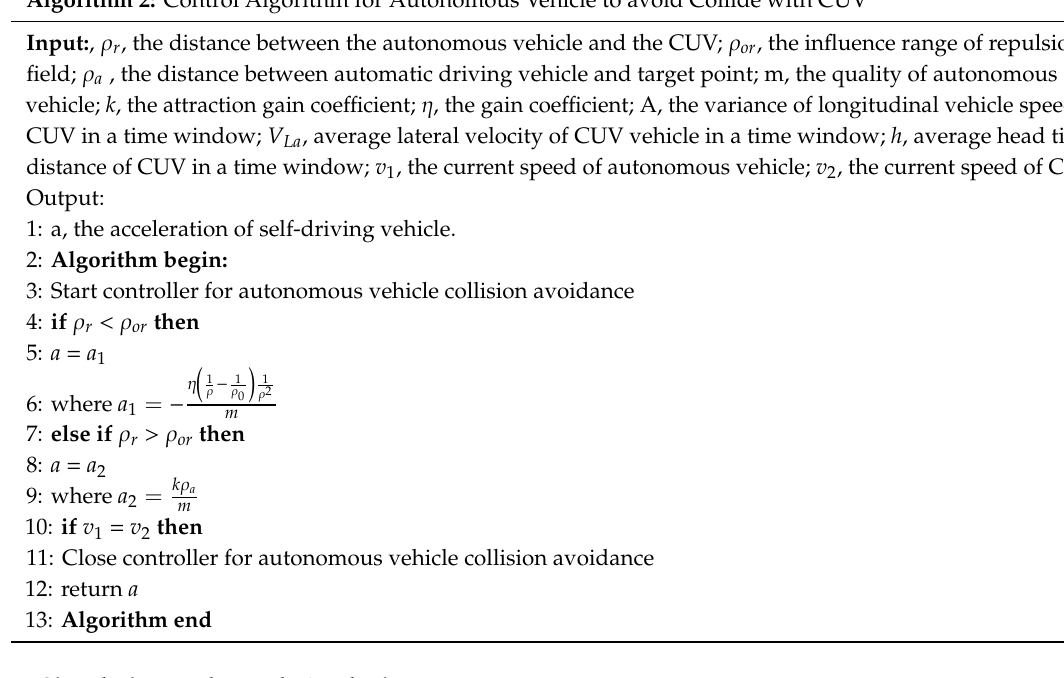
Algorithm 2: Control Algorithm for Autonomous Vehicle to avoid Collide with CUV